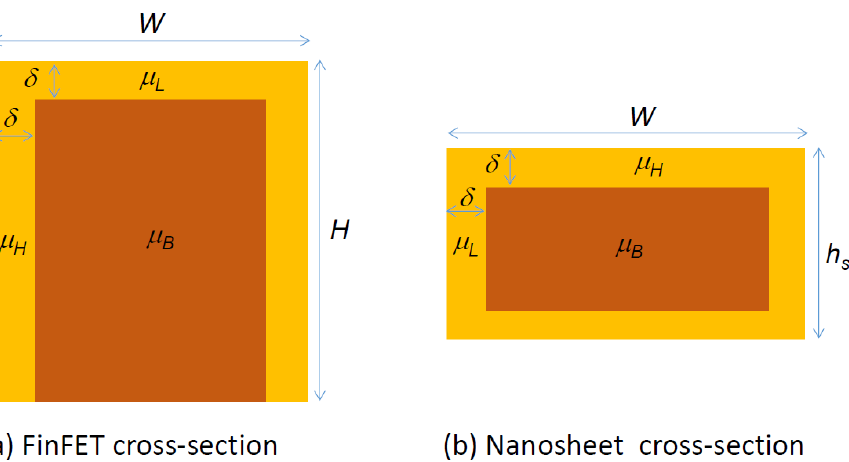
Figure 4. Cross-sectional view of ( a ) FinFET and ( b ) a single nanosheet with the best crystal orien- tation alignment for maximizing the current conduction for the high surface mobility, µ H , and low surface mobility, µ L . δ represents the rough surface layer which could lead to a significant mobility degradation as the size of the fin or nanosheet become smaller.